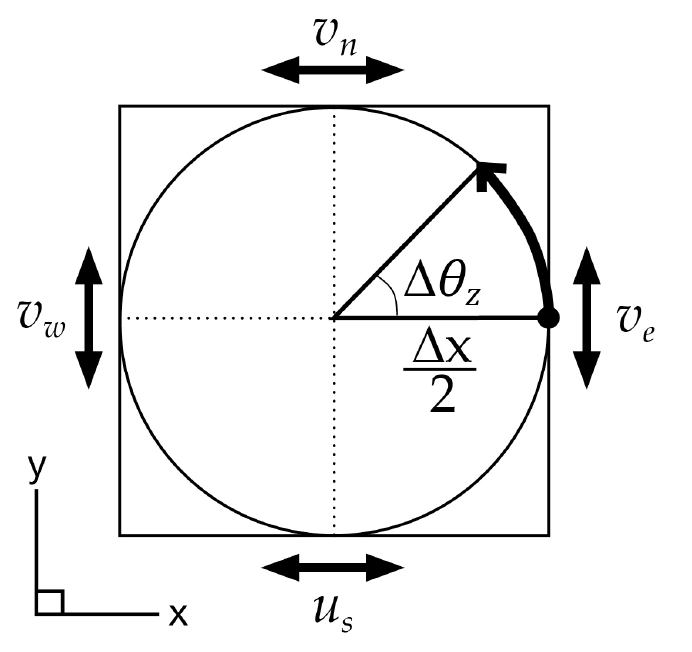
Figure 1. Displacement-derived arc construction used to calculate ∆ θ z . The face of the volume chosen is arbitrary and does not alter the angle